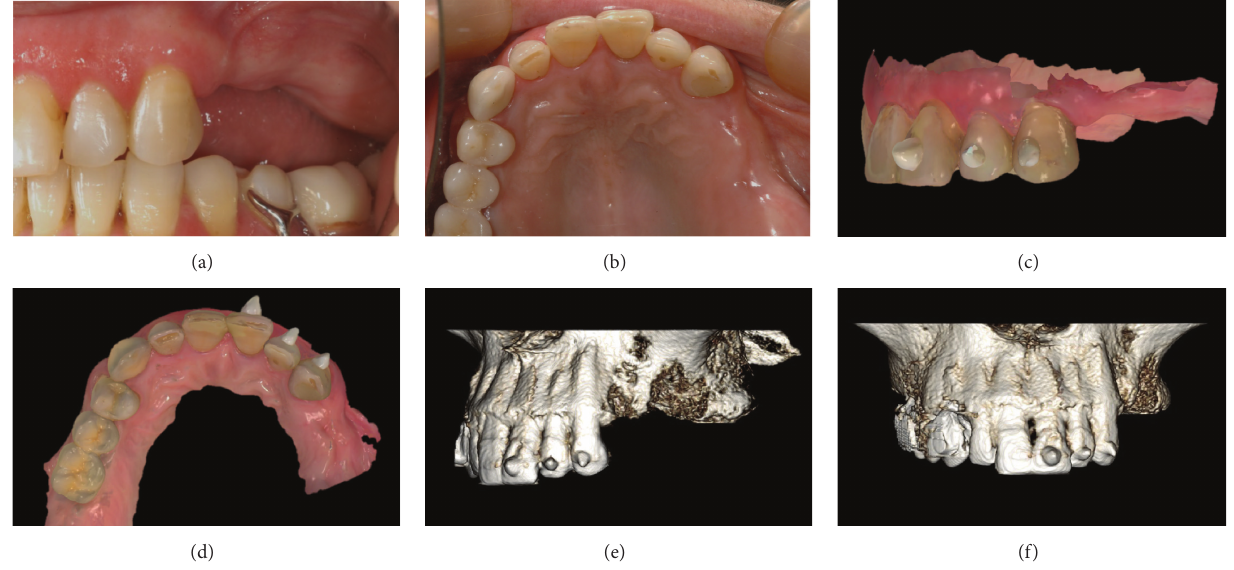
Figure 1: Image acquisition: (a) preoperative clinical picture, side view; (b) preoperative clinical picture, occlusal view; (c) intraoral scan with references, side view; (d) intraoral scan with references, occlusal view; (e) CBCT volume rendering with references, side view; (f) CBCT volume rendering with references, frontal view.